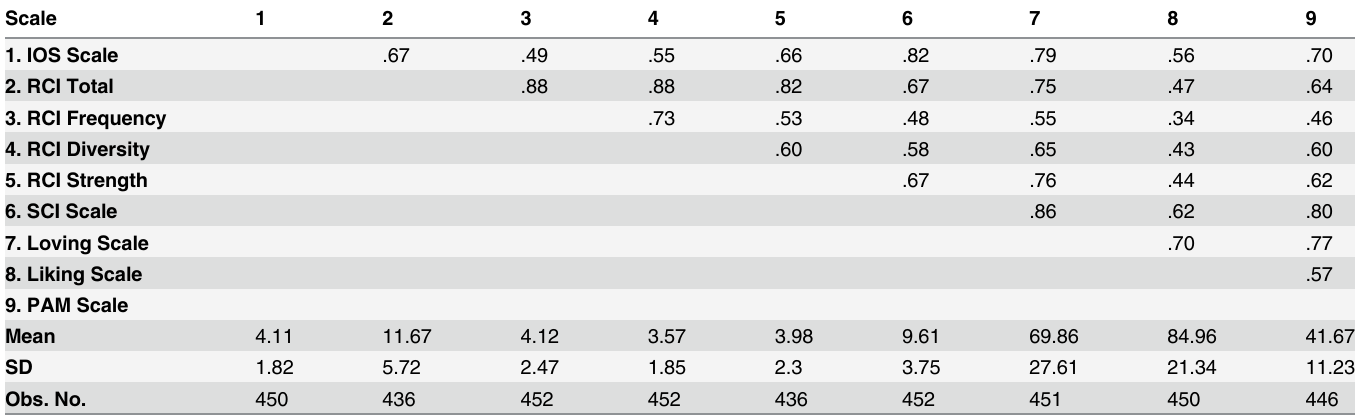
All correlations are signi fi cant at p <